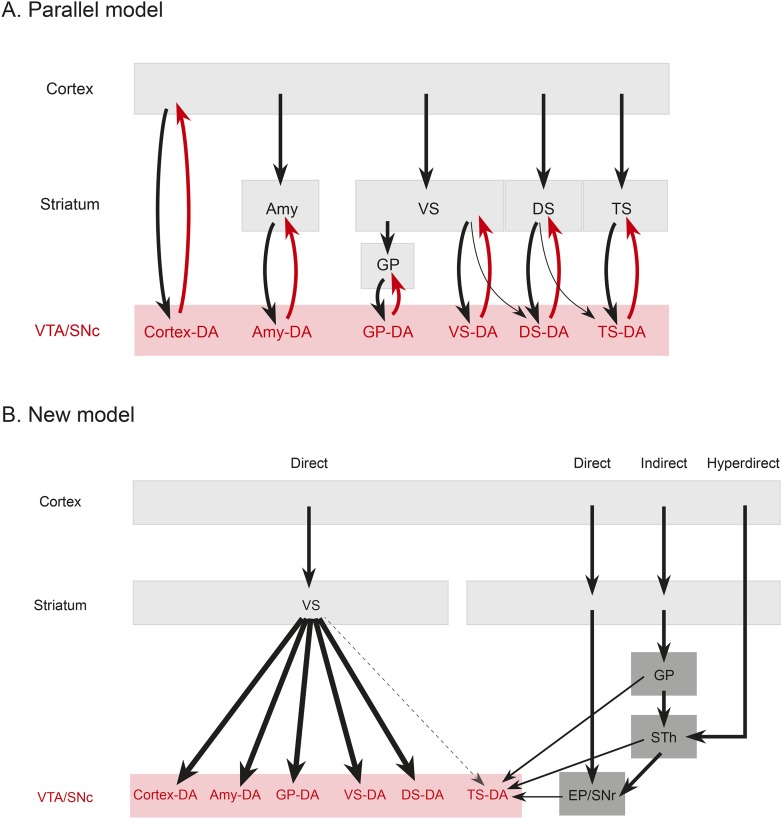
Summary and model.(A) A working model suggesting that dopamine neurons receive inputs primarily from the region that they project to, based on the idea that input neurons provide an ‘expectation’ signal and dopamine neurons correct them (i.e., send them a prediction error signal based on the type of expectation that they encoded) individually. (B) Our model, in which dopamine neurons in the ‘canonical’ pathway receive inputs primarily from a common set of regions (and particularly heavy inputs from the ventral striatum) and send a common prediction error signal to many parts of the forebrain. We propose that TS-projecting dopamine neurons could be part of a relatively separate pathway with a potentially unique function (different from reward prediction error (RPE) calculation) based on its unique distribution of inputs. Some common inputs such as the DS and ventral pallidum are omitted for clarity.